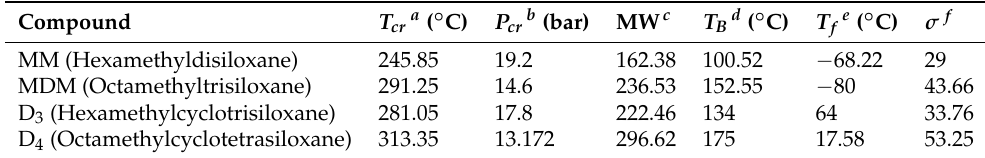
Table 3. Some thermodynamic properties of two linear and two cyclic siloxanes.